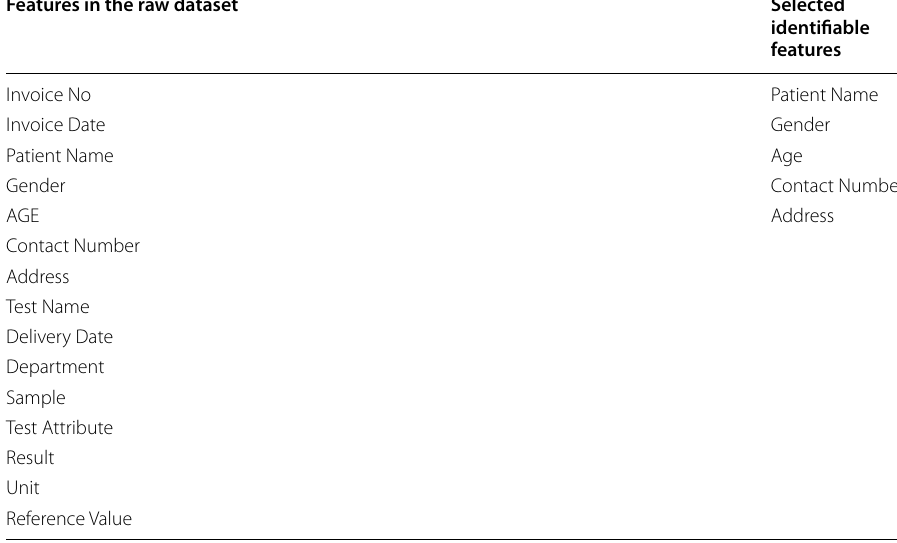
Table 1 Feature Selection Features in the raw dataset